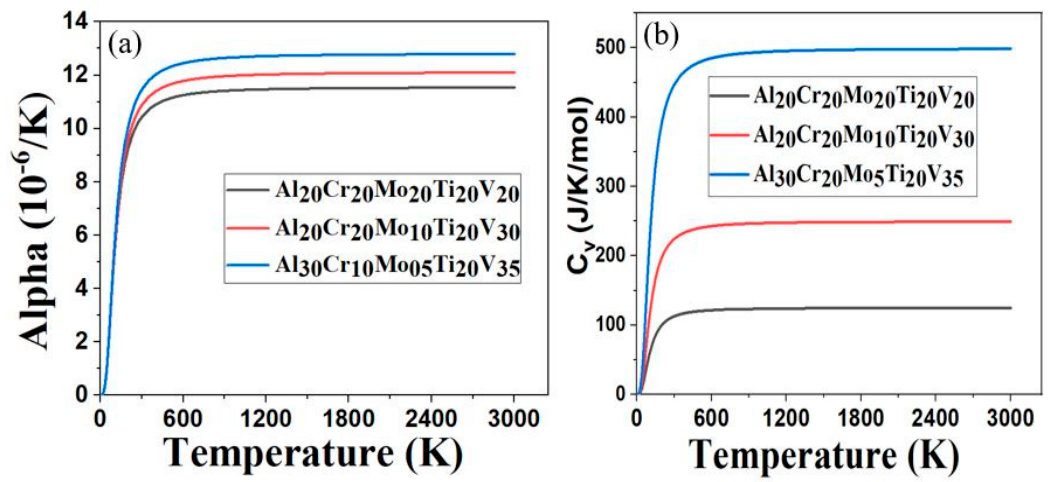
Figure 3. ( a ) Thermal coefficient of linear expansion as a function of temperature; ( b ) Specific heat capacity at constant volume as a function of temperature.